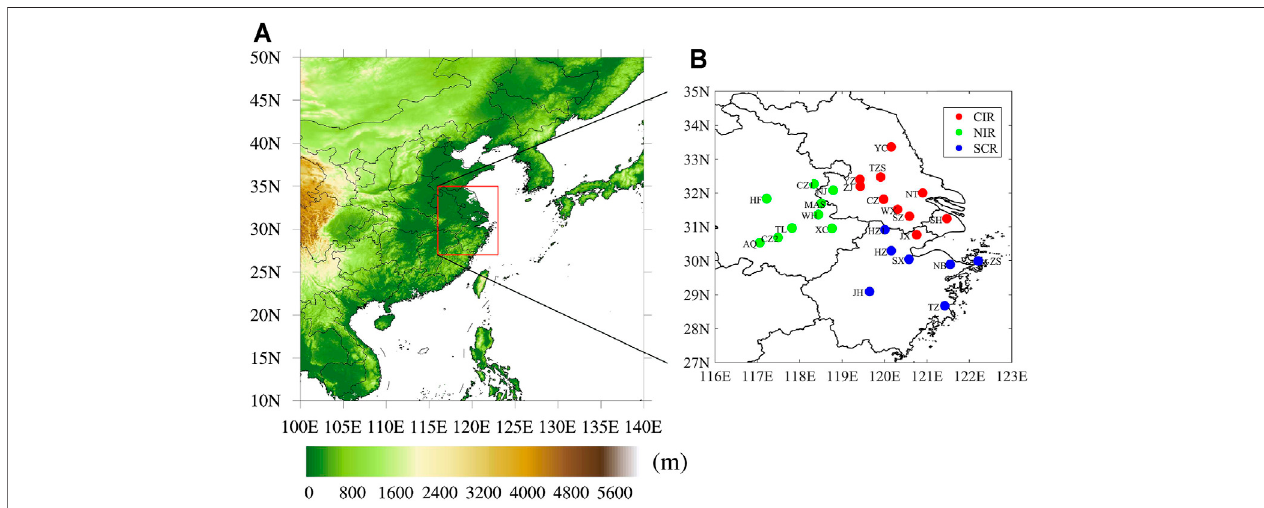
FIGURE 1 | The geographic information of the YRD region, including (A) its location in China with terrain elevation data and (B) the 26 typical YRD cities. In (B) , the cities include Nanjing (NJ), Wuxi (WX), Changzhou (CZ), Suzhou (SZ), Nantong (NT), Yancheng (YC), Yangzhou (YZ), Zhenjiang (ZJ), Taizhoushi (TZS), Hangzhou (HZ), Ningbo (NB), Jiaxing (JX), Huzhou (HZ1), Shaoxing (SX), Jinhua (JH), Zhoushan (ZS), Taizhou (TZ), Hefei (HF), Wuhu (WH), Maanshan (MAS), Tongling (TL), Anqing (AQ), Chuzhou (CZ1), Chizhou (CZ2), Xuancheng (XC) and Shanghai (SH). CIR, NIR and SCR respectively represent the cities in the Central Inland, the Northwest Inland and the Southeast Coastal Region, which are discussed in Spatiotemporal Distribution of O 3 Section in details.